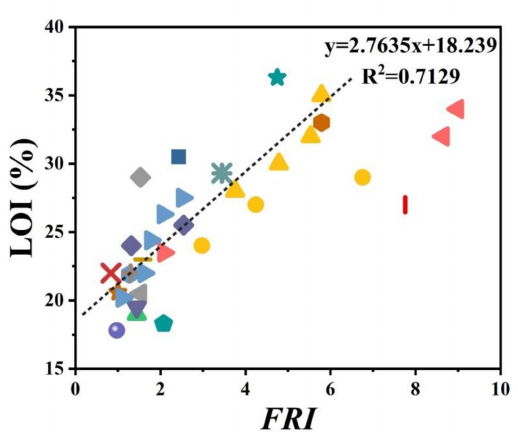
Figure 6. FRI values of PP as a function of LOI test results. Symbols are indicative of di ff erent types of nitrogen flame retardant used.